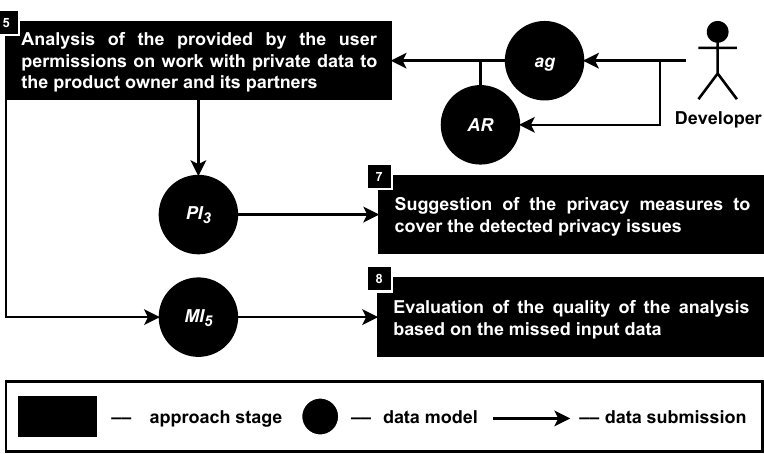
Figure 8. Stage 5—Analysis of the user’s permissions to work with private